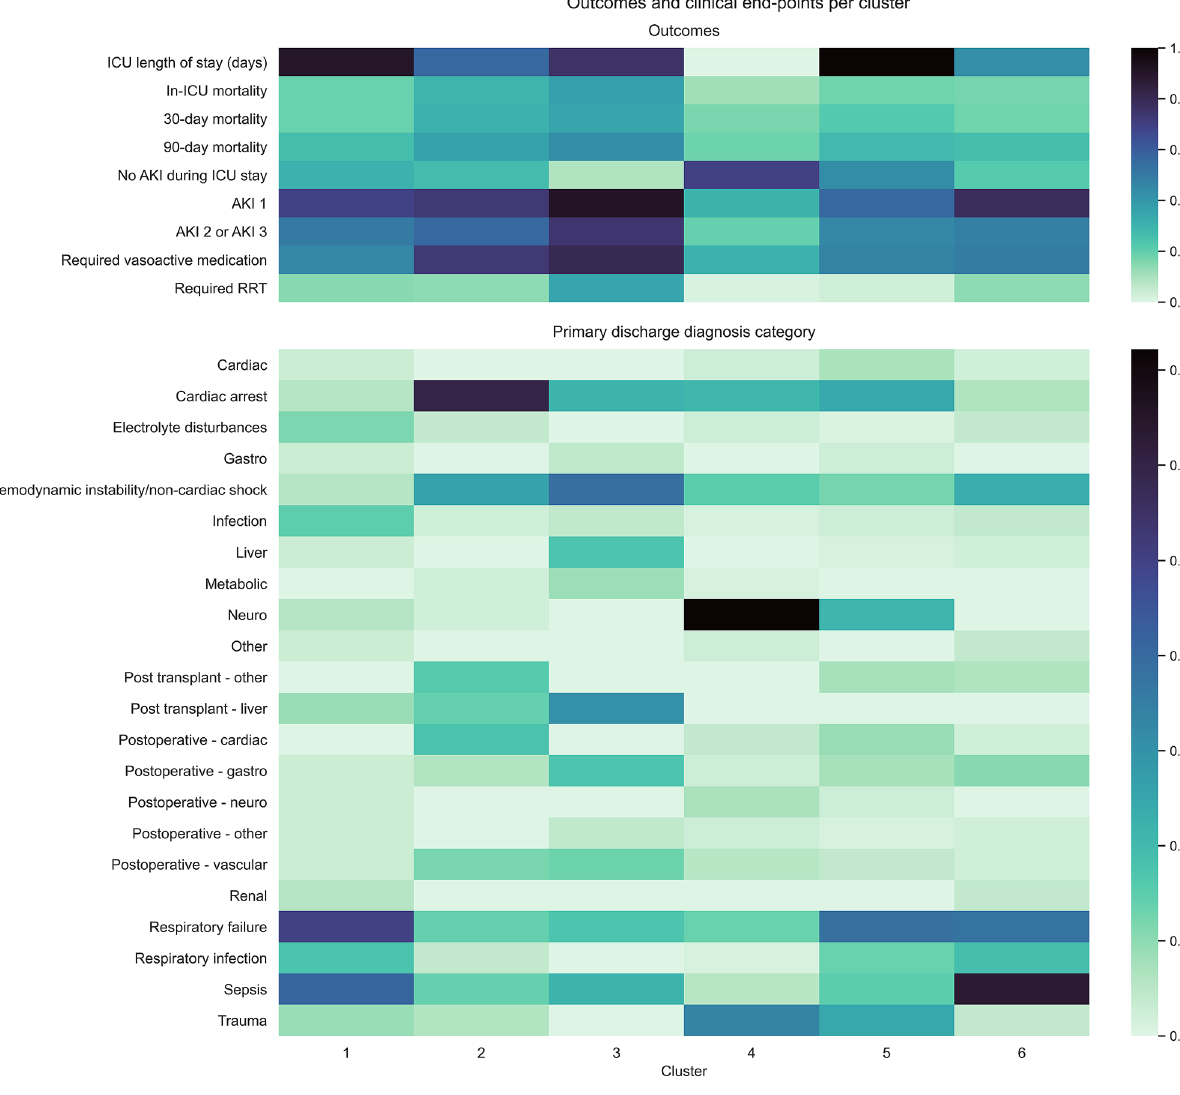
Figure 3. Heatmap of outcomes and clinical end-points per cluster. Bars on the right show the colour scale representing the proportion of patients within the cluster with the outcome (upper panel) or the discharge diagnosis (lower